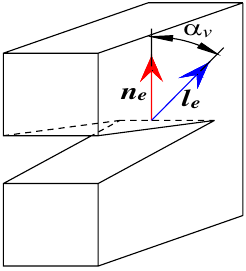
Figure 6. Schematic diagram of the angle for characterizing fracture